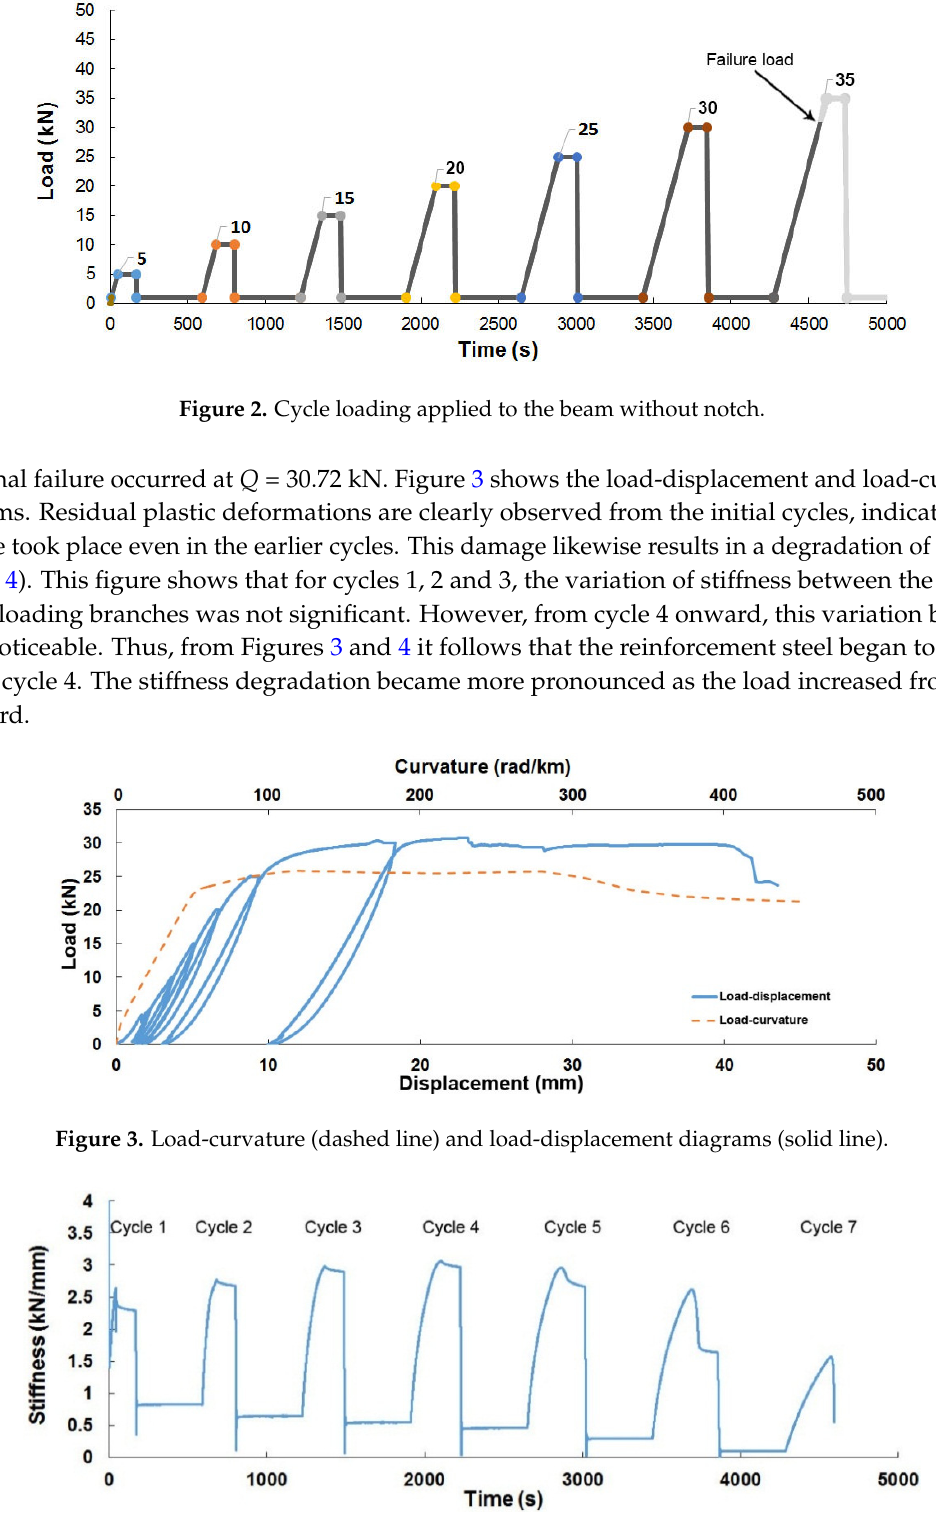
Figure 4 . Stiffness degradation of the beam without notch.